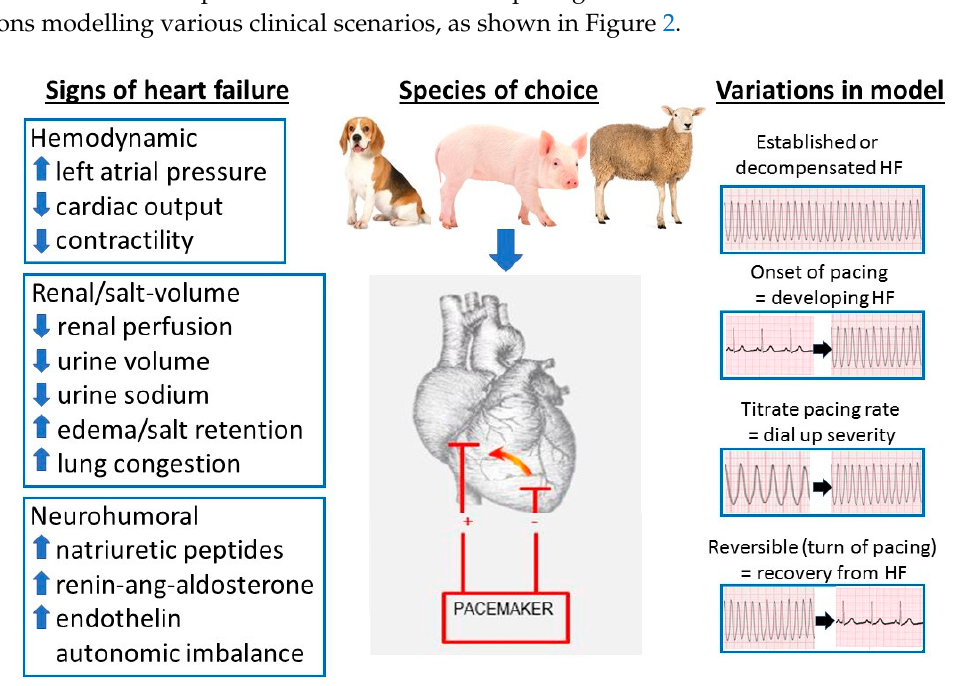
Figure 2. Variations of the large animal model of pacing-induced heart failure showing species of choice and key integrative hemodynamic, renal and neurohumoral signs of heart failure.